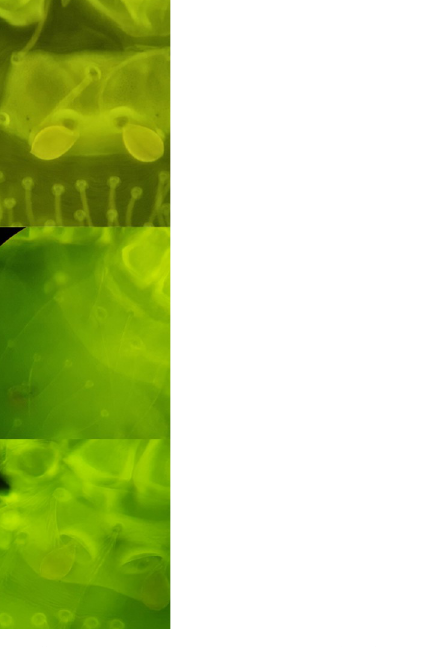
Fig 3. Trombiculids observed with an epifluorescence microscope prior to molecular analysis. A. Herpetacarus eloisae . B. Herpetacarus antarctica . C. Paratrombicula goffi . D. Paratrombicula neuquenensis . E. Quadraseta chiloensis . F. Argentinacarus expansus